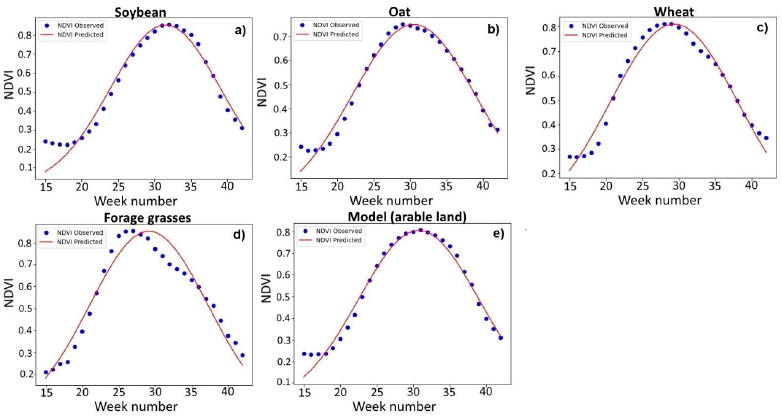
Figure 4. Observed and approximated weekly NDVI composites (15th–42nd calendar weeks) for the experimental fields in the Khabarovsk District in 2018: ( a ) Soybean fields; ( b ) oat fields; ( c ) spring wheat fields; ( d ) forage grass fields; ( e ) total (arable land model).